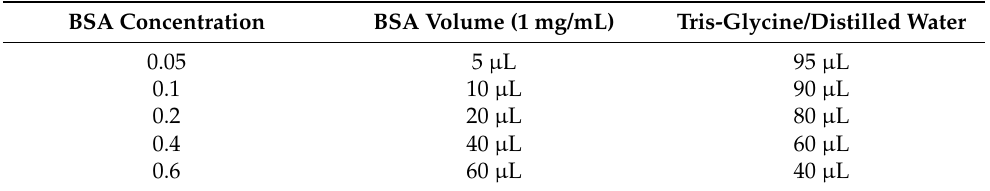
Table 2. The used concentrations for the calibration curves.